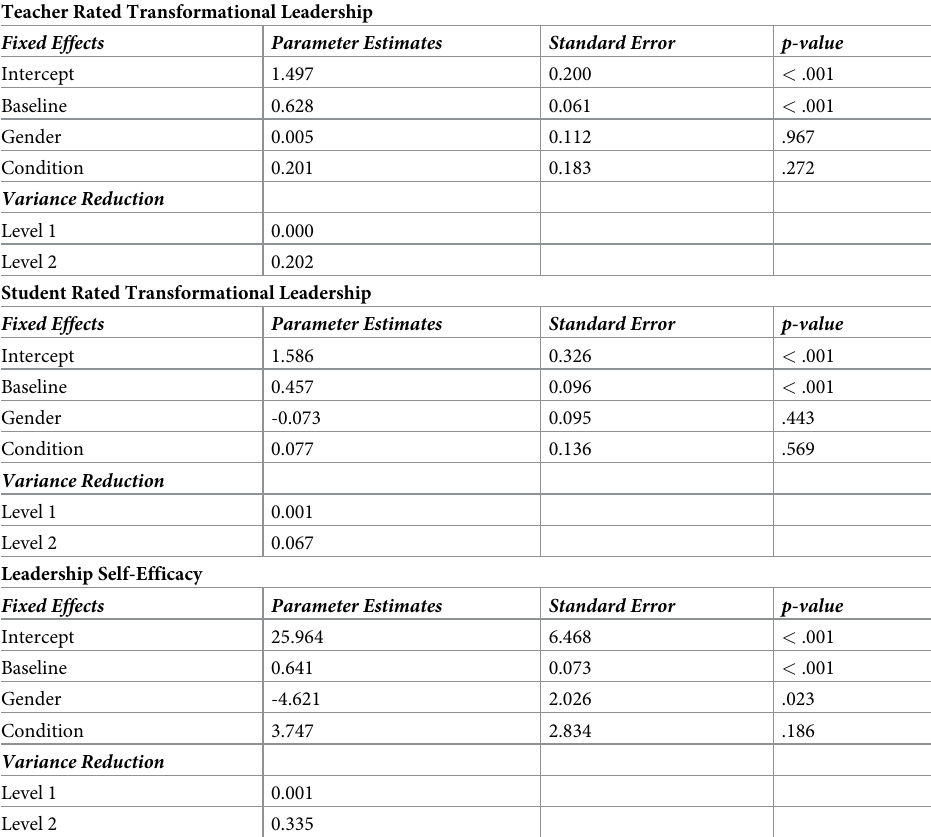
Table 3. Grade 6/7 outcome